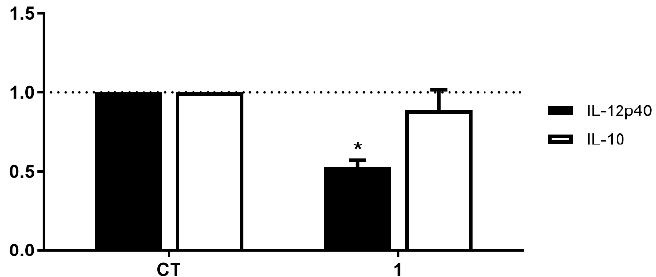
Figure 3. The effect of geobarrettin D ( 1 ) on DC secretion of IL-12p40 and IL-10. DCs were matured and activated with IL-1 β , TNF- α and LPS for 24 h in the absence (solvent control (CT)) or presence of geobarrettin D ( 1 ) at 10 µ g/mL. The concentrations of IL-12p40 and IL-10 in the supernatants were determined by ELISA. The data are presented as SI, i.e., the concentration of each cytokine in the supernatant of cells cultured in the presence of compound 1 divided by the concentration of the cytokine in the supernatant of cells cultured without compound 1 . The results are shown as mean ± SEM, n = 3. Di ff erent from CT: * p ˂ 0.05.